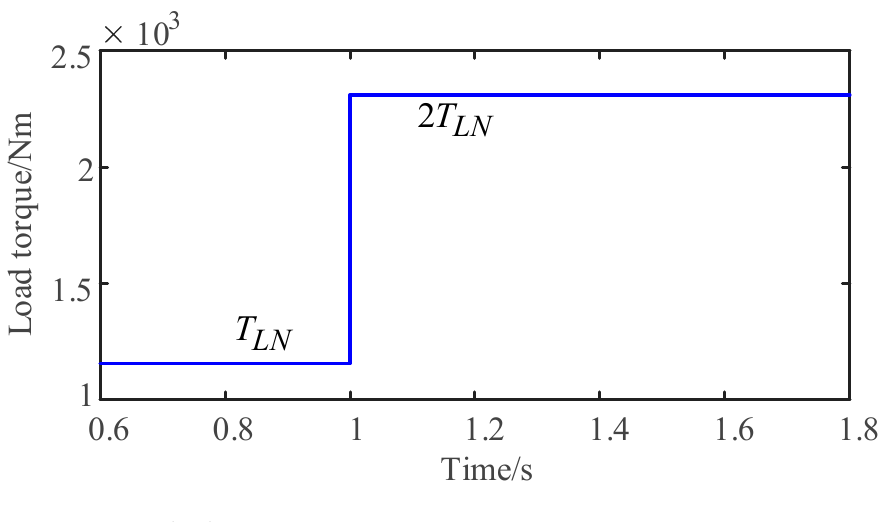
Table 6. Parameter of the system under impact conditions.